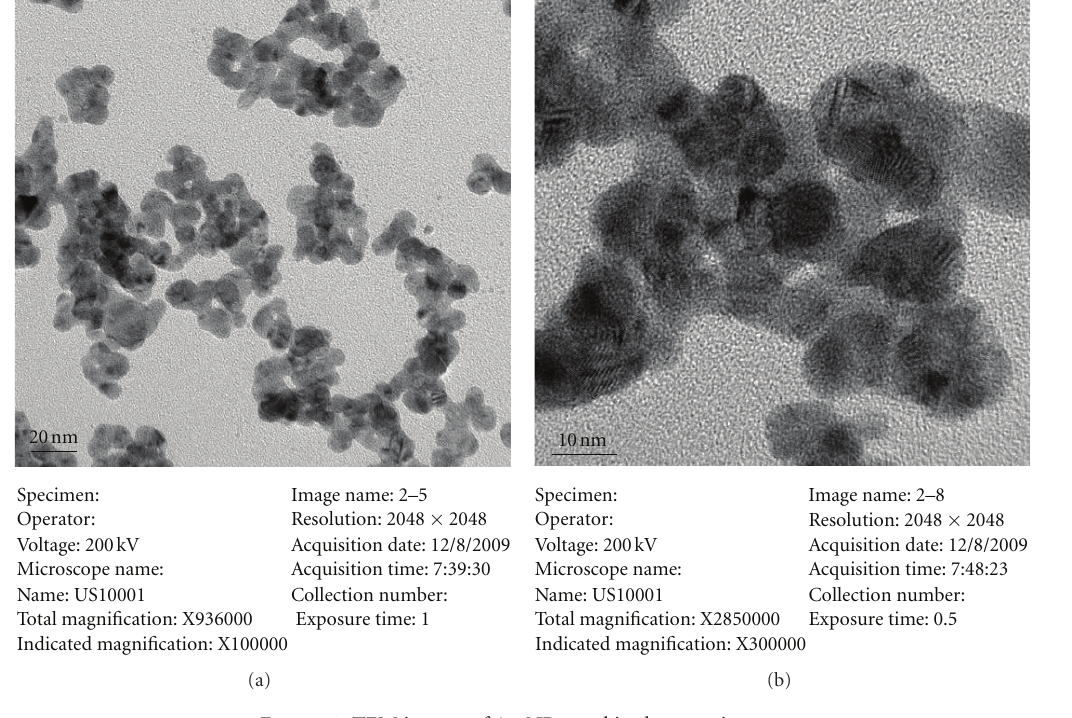
Figure 1: TEM images of Ag-NPs used in the